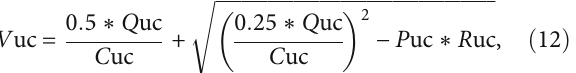
Figure 2: Master-slave salp swarm algorithm fl